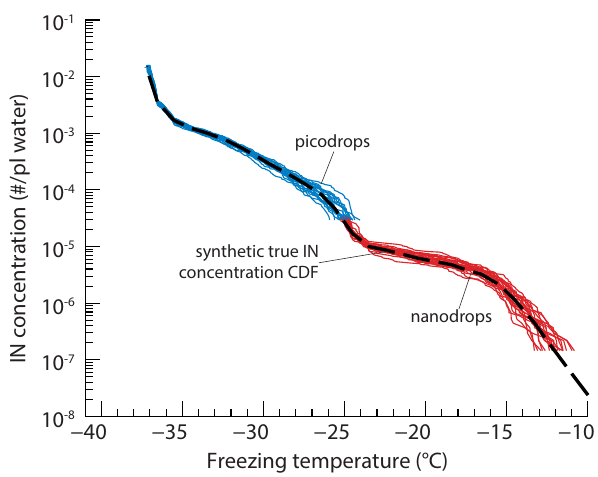
Figure 2. Dashed line: synthetic IN concentration used to generate a randomized instance mimicking the number and size distribution of picodrop and nanodrop experiments shown in Fig. 1c and d. Blue and red lines: inverted IN concentrations for a simulated single ex- periment using Eq. (4) for picodrop and nanodrop experiments, re- spectively.